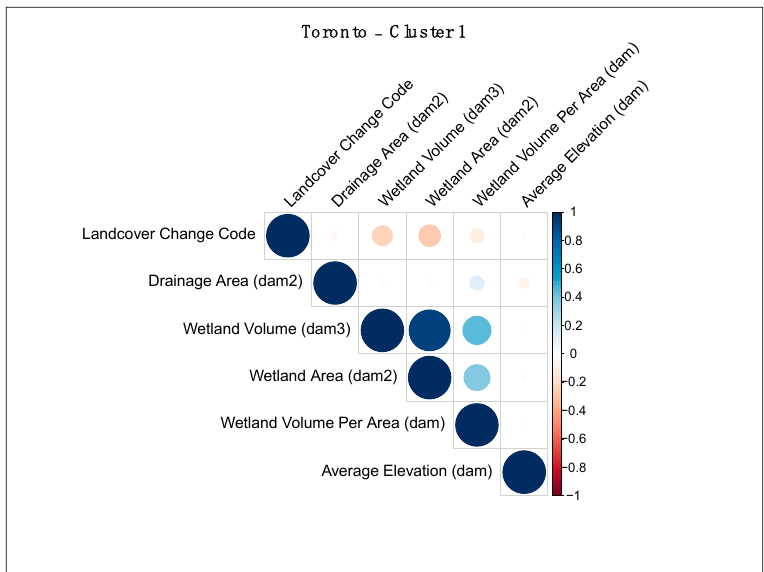
Figure 2. Toronto cluster 1 correlation matrix.